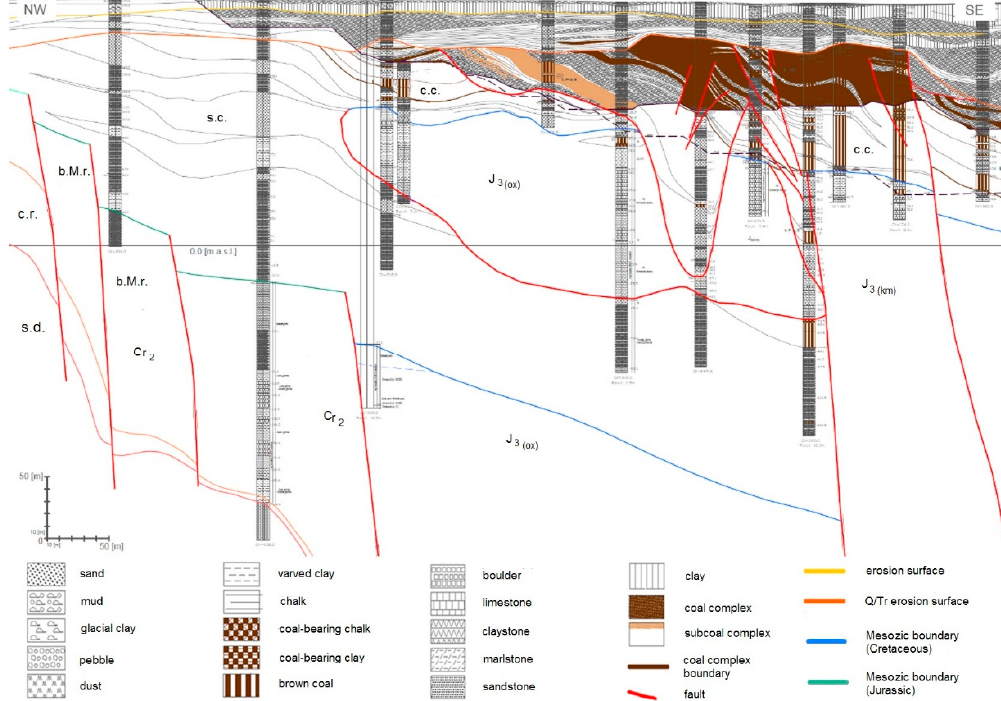
Figure 4. The cross section IIIa (right middle part of the Figure 3), which illustrates the elements projected by the three-dimensional (3D) numerical model.